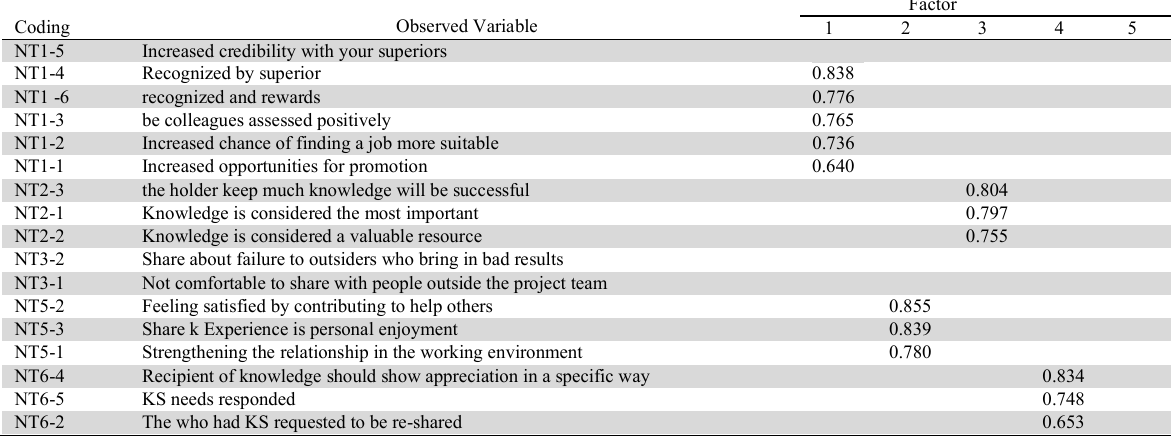
Factor analysis results for independent variables